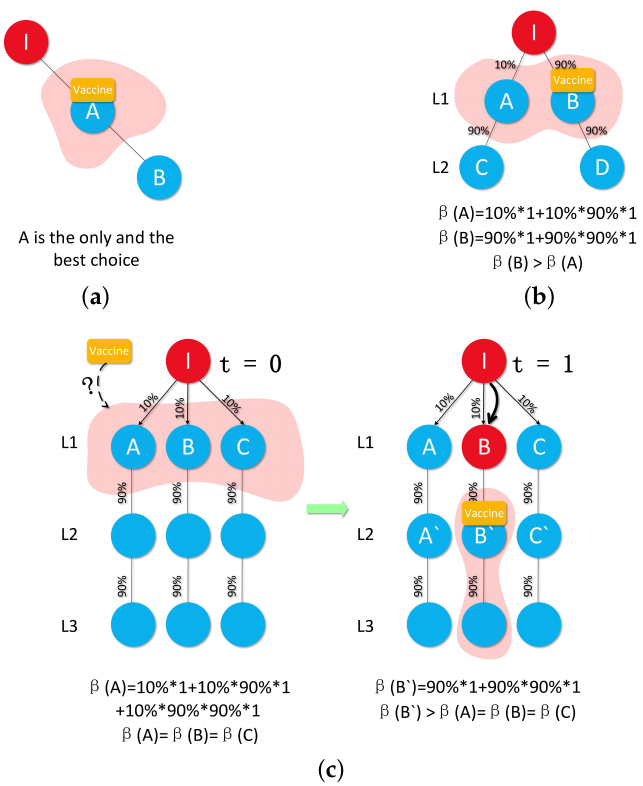
Figure 5. Examples for one vaccine: A simple case like Simple Case 1 that we can put the only one vaccine on node A with no doubt. Simple Case 2 is also not a hard decision for us. After comparing the benefit between A and B, we can put vaccine on B to obtain a bigger V B . However, in DVP Case , after investigating the difference of V B between t = 0 and t = 1, surprisingly, we discovered V t = 0 < V t = 1 . That is to say, the value of V B is changed by time, in addition, a bigger V B can be B B obtained by another time. There is a big difference between waiting some time slots and without waiting. In previous assumption, we must put the V on G ( V , E ) at t = 0 which means they could not get the bigger V t = 1 . ( a ) Simple Case 1; ( b ) Simple Case 2; ( c ) DVP B